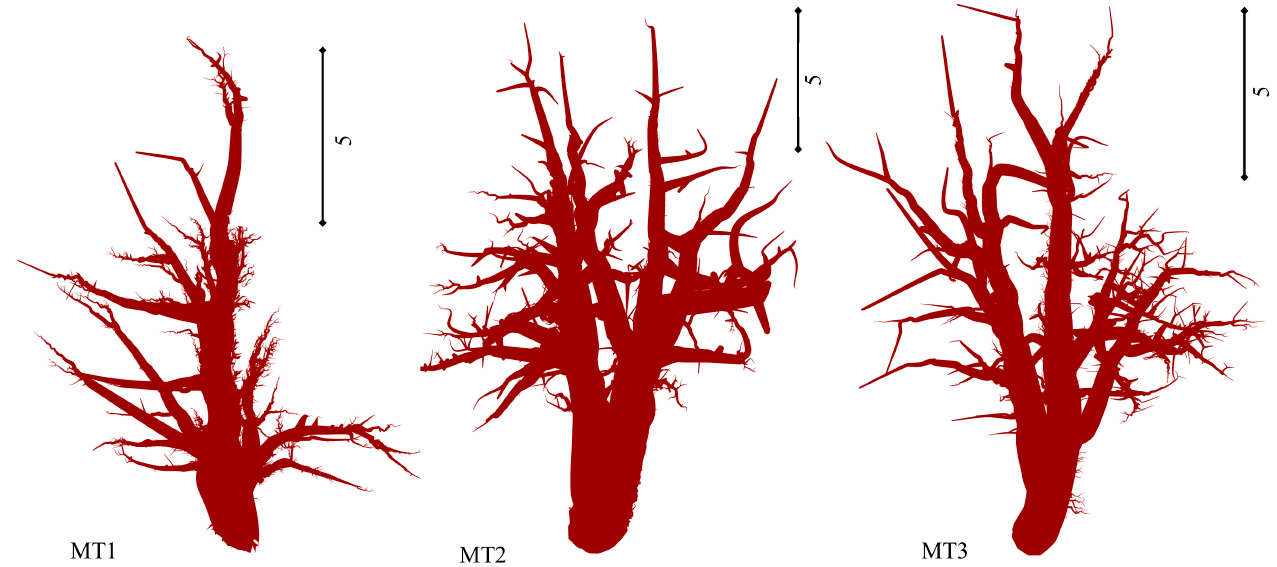
Figure 8. Mesh representation of the three MLS tree skeletons in the winter surveys (MT1, MT2 and MT3) by AdQSM (visualization in CloudCompare).